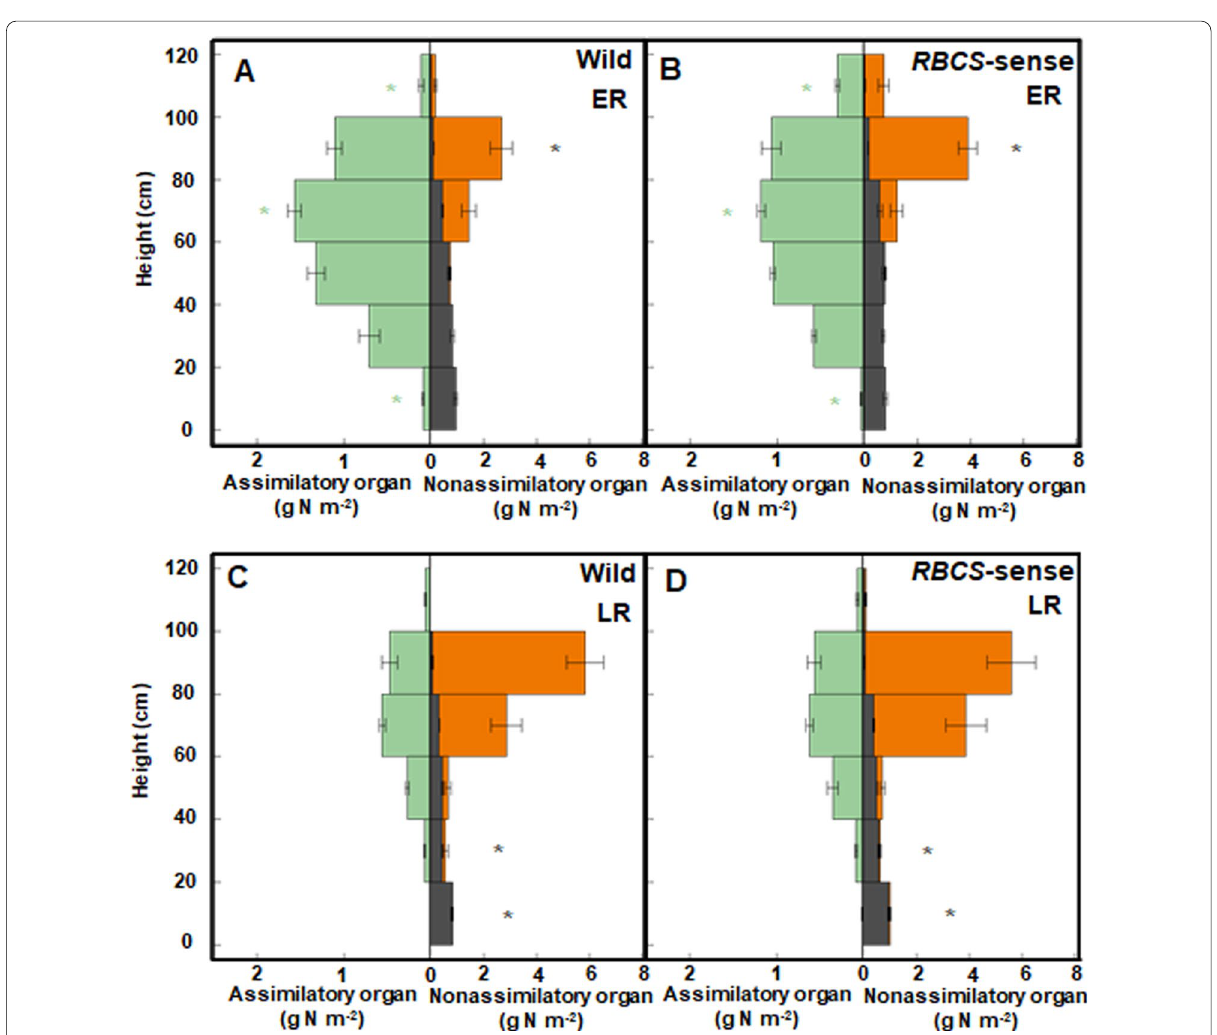
Fig. 5 Changes in the vertical distribution of N content in the canopies of the wild‑type ( A and C ) and RBCS ‑sense rice plants ( B and D ) at 10 DAH in early and 49 DAH in late ripening stages in plots applied with 15 g N m − 2 fertilizer. Mean values plots are indicated. * p < 0.05 between the wild‑type and RBCS ‑sense rice plants using Student’s t- test. The N contents of leaf blades, panicles, and sheathes and stems are represented by green, orange, and dark gray bars, respectively. The abbreviations stand as following: “ER”; early ripening stage, “LR”; late ripening stage, “N”; nitrogen, “ RBCS ‑sense”; transgenic rice plants overproducing Rubisco, “Wild”; wild‑type rice